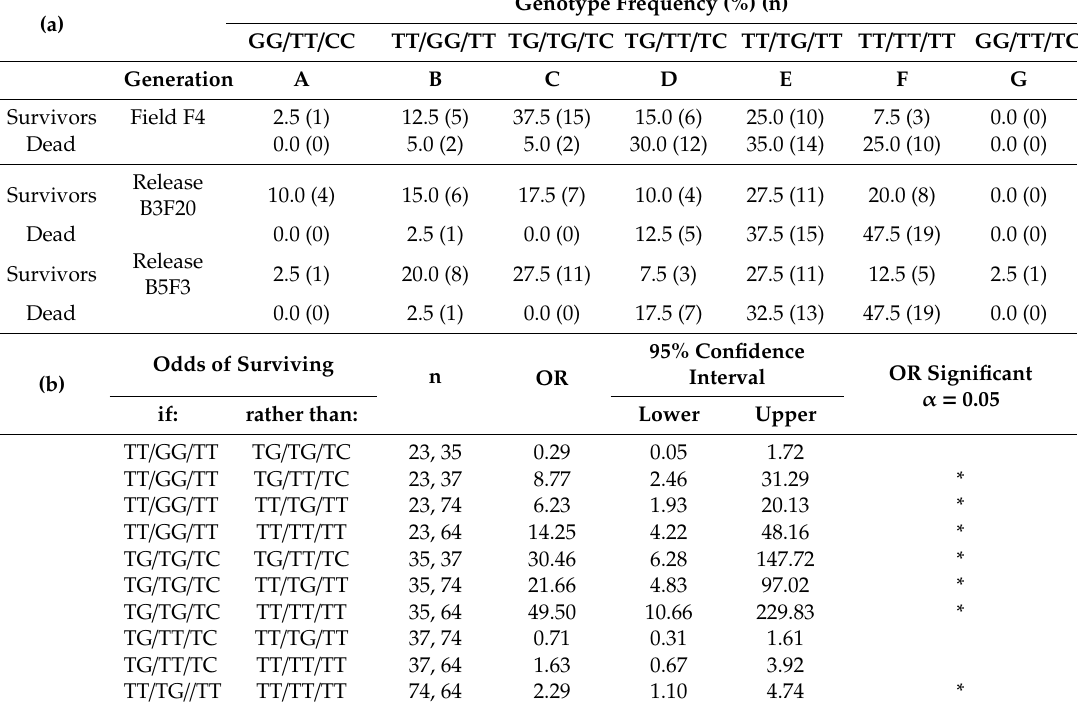
Table 3. ( a ) Vssc genotypes of survivors and dead female Aedes aegypti from the field and the laboratory release colony from WHO bioassays with deltamethrin (0.03%) (order of mutation sites 1016 / 1534 / 989) (Field = Shah Alam F4, laboratory colony was tested at B3F20 and B5F3). ( b ) Odds ratios (OR) of surviving deltamethrin (type II pyrethroid) when a particular genotype is compared with another are also given.